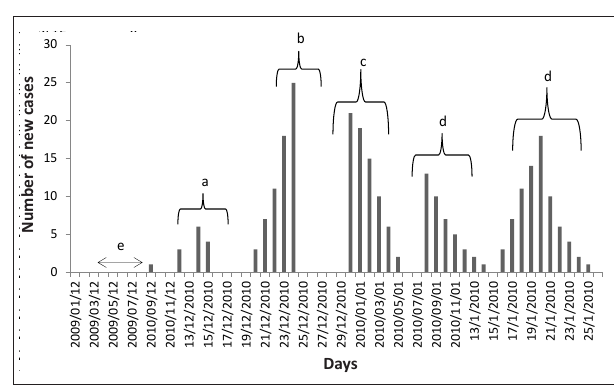
Note: Results recorded during December 2009 and January 2010. FIGURE 3: Epidemic curve of peste des petits ruminants outbreak in the Newala district of the Mtwara region in southern